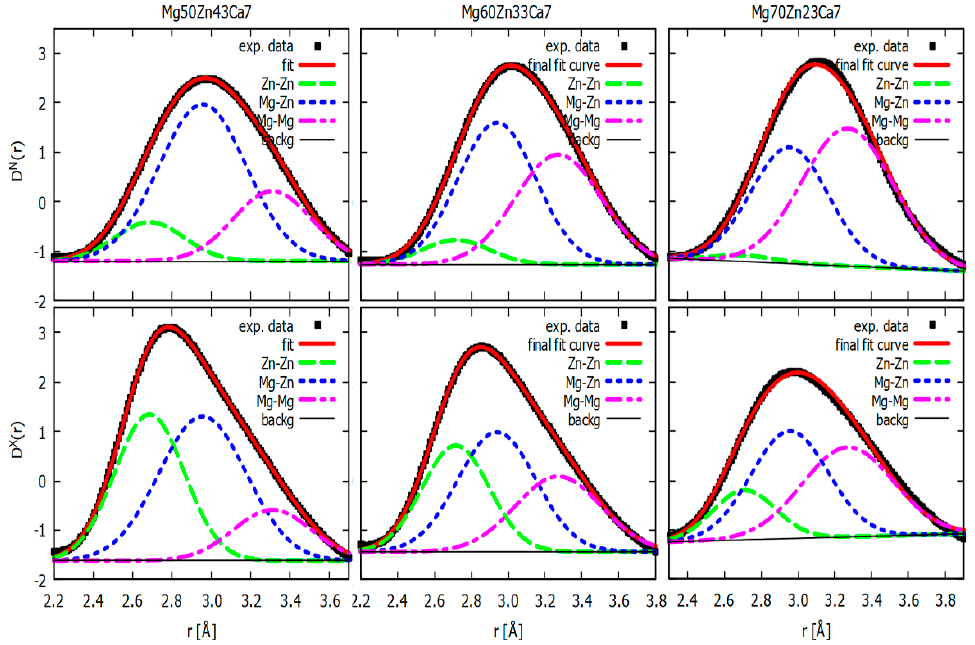
Figure 4. Decomposition of the first D X ( r ) and D N ( r ) into three Gaussians representing ZnZn, MgZn, and MgMg pairs for Mg 50 Zn 43 Ca 7 , Mg 60 Zn 33 Ca 7 , and Mg 70 Zn 23 Ca 7 . Table 4. Fitted Gaussian parameters representing ZnZn, MgZn, and MgMg pairs for Mg 50 Zn 43 Ca 7 , Mg 60 Zn 33 Ca 7 , and Mg 70 Zn 23 Ca 7 . Errors of individual parameters correspond to the fitting errors. “ZnZn” Gaussian “MgZn” Gaussian “MgMg”